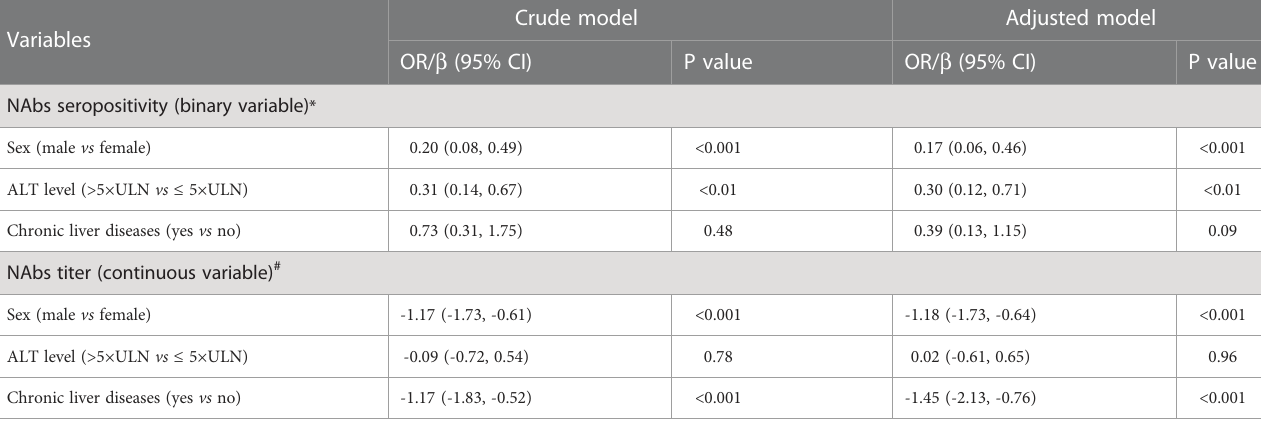
TABLE 2 Multiple regression analysis of risk factors associated with NAbs response to COVID-19 vaccines in patients with liver dysfunction. Crude model Adjusted model Variables